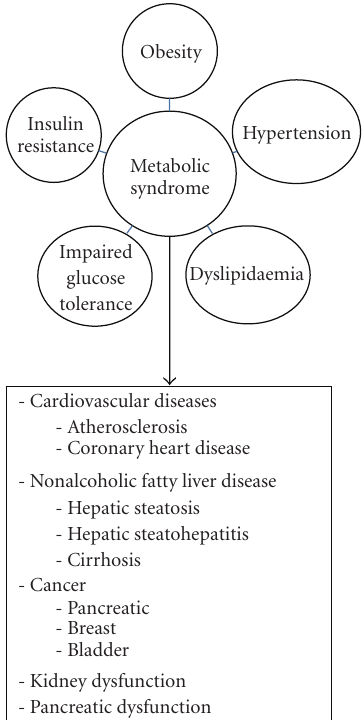
Figure 1: Metabolic syndrome and associated complications.